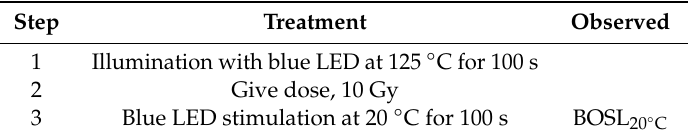
Table 4. Sequence of procedures to measure BOSL 20 ◦ C sensitivity in aliquots of fine-grained sediments from core